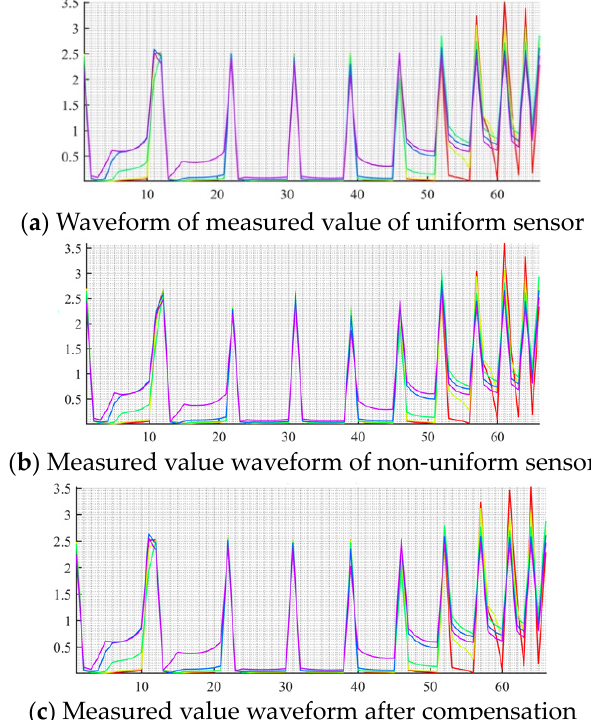
Figure 7. Waveforms of measured values before and after laminar flow compensation.